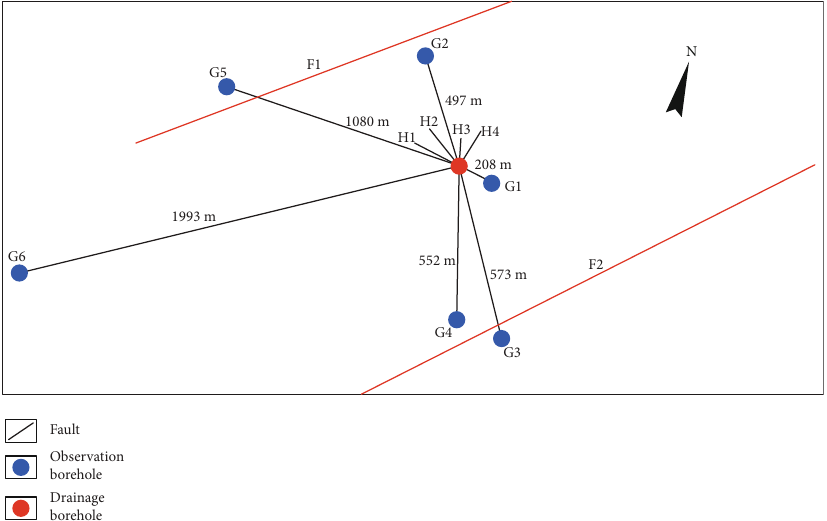
Figure 5: Plane fi gure of water drainage